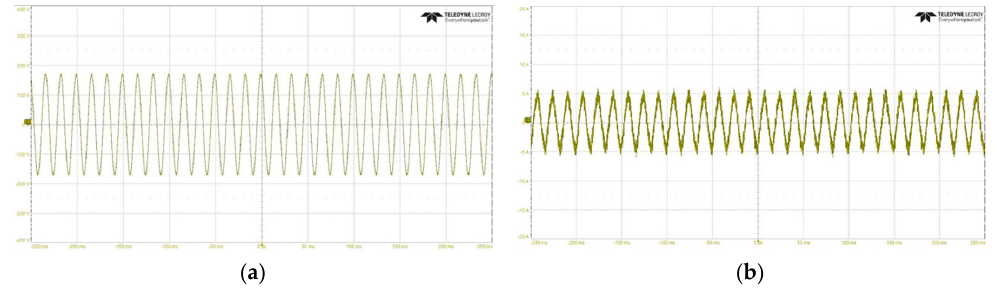
Figure 10. Experimental results of ( a ) grid voltage and ( b ) phase current when the proposed single-phase current control method is applied.